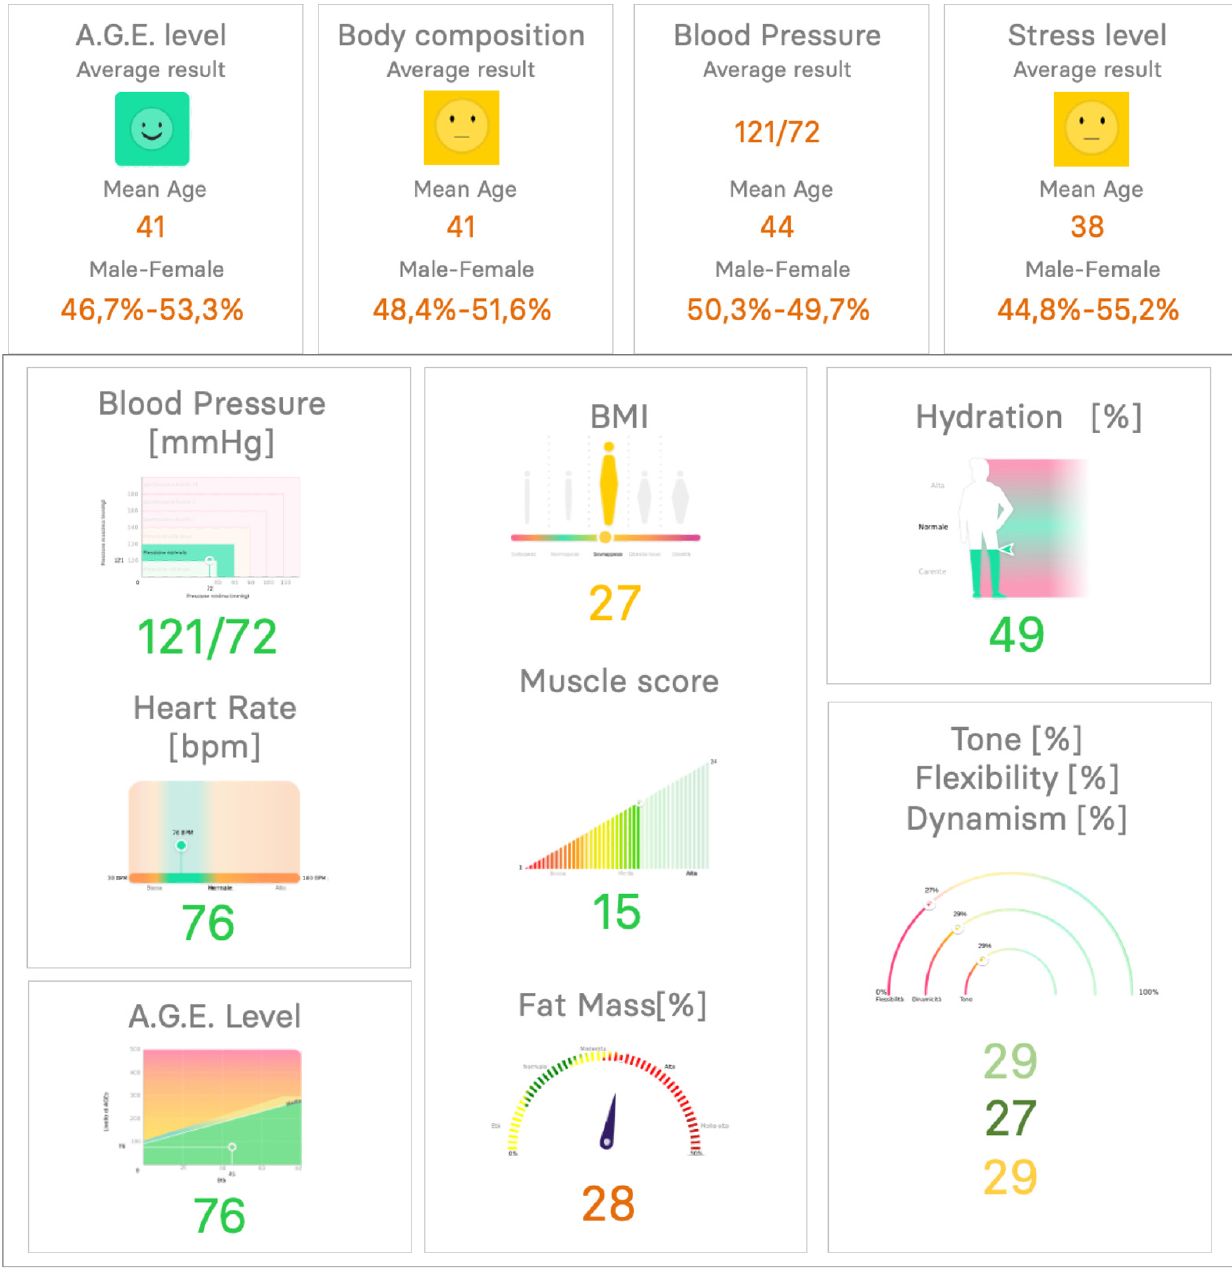
Figure 5. Global outcome of the health status of the population that participated in health pod pilot tests at S1 and S2. Semaphoric color-coding of the represented numbers shows the potential difference from the considered normality levels.